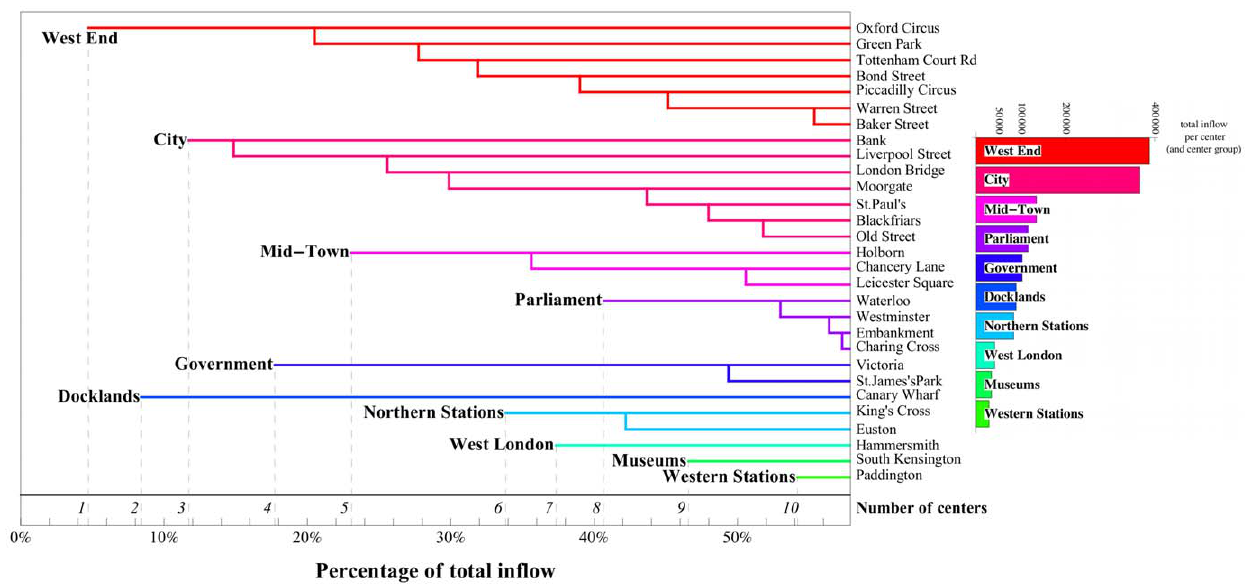
Figure 4. Hierarchical organization of the activity: Polycenters. Breakdown of centers in terms of underlying stations and inflows. We gather stations by descending order of total inflow and we aggregate the stations to centers when taking into account more and more stations. In this process, all stations within 1,500 meters of an already-defined center are aggregated to this main center. This yields the dendrogram shown here which highlights the hierarchical nature of the polycentric organization of this urban system. The bold names to the left of the aggregates — such as ‘‘ West End ’’ for the group of stations around Oxford Circus — are used throughout the paper as convenient labels to denote the polycenters.